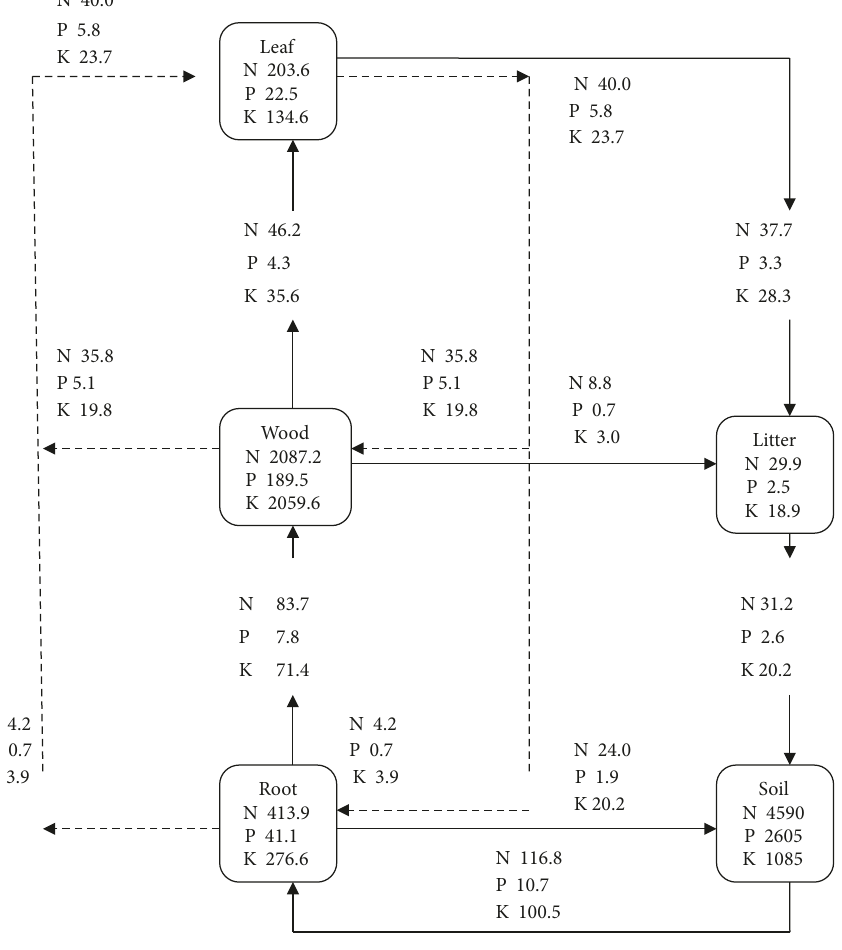
Figure 4: Model showing the distribution and cycling of nutrients, N, P, and K in disturbed forest stand of moist tropical forest of Sunsari district eastern Nepal. Values inside compartments represent nutrient stocks (kg ha – 1 ). Internal recycling is represented by the broken lines. Net annual fluxes between compartments are representedas arrows (kg ha – 1 yr – 1 ). The root compartment includes coarse as well as fine roots. The wood compartment also includes aboveground nonleaf part of herbs (especially of the perennial